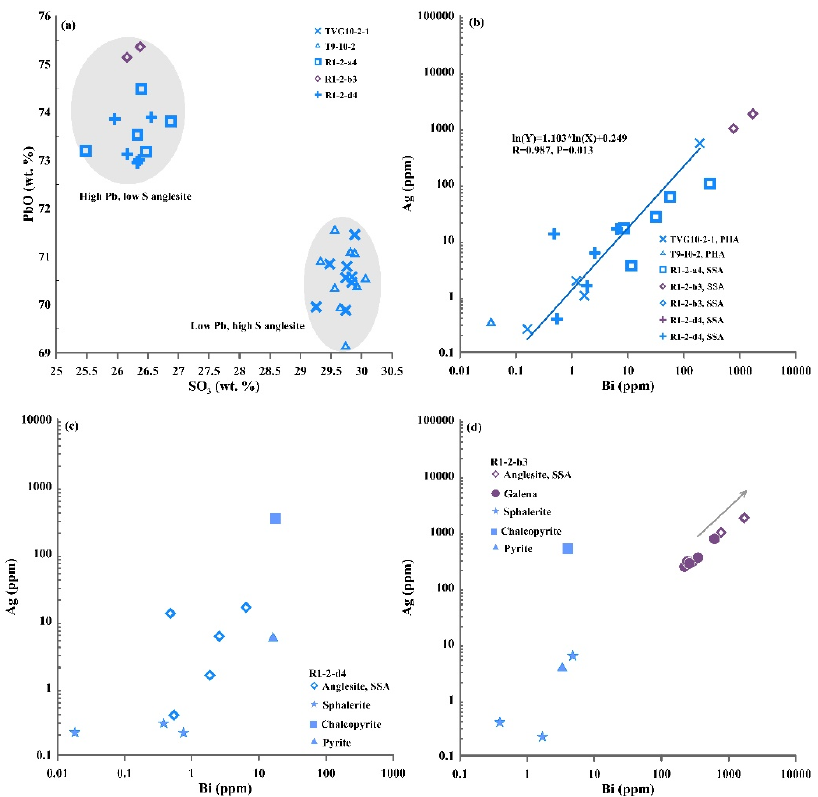
Figure 6. Plots of anglesite minerals in samples H2-R1-2-a4, b3, d4 (MOT hydrothermal field) and samples H3-T9-10-2 and H4-TVG10-2-1 (SOT hydrothermal field): ( a ) PbO vs. SO 3 ; ( b ) Ag vs. Bi; ( c ) Ag vs. Bi in sample H2-R1-2-d4; ( d ) Ag vs. Bi in sample H2-R1-2-b3. PHA—primary hydrothermal anglesite; SSA—secondary supergene